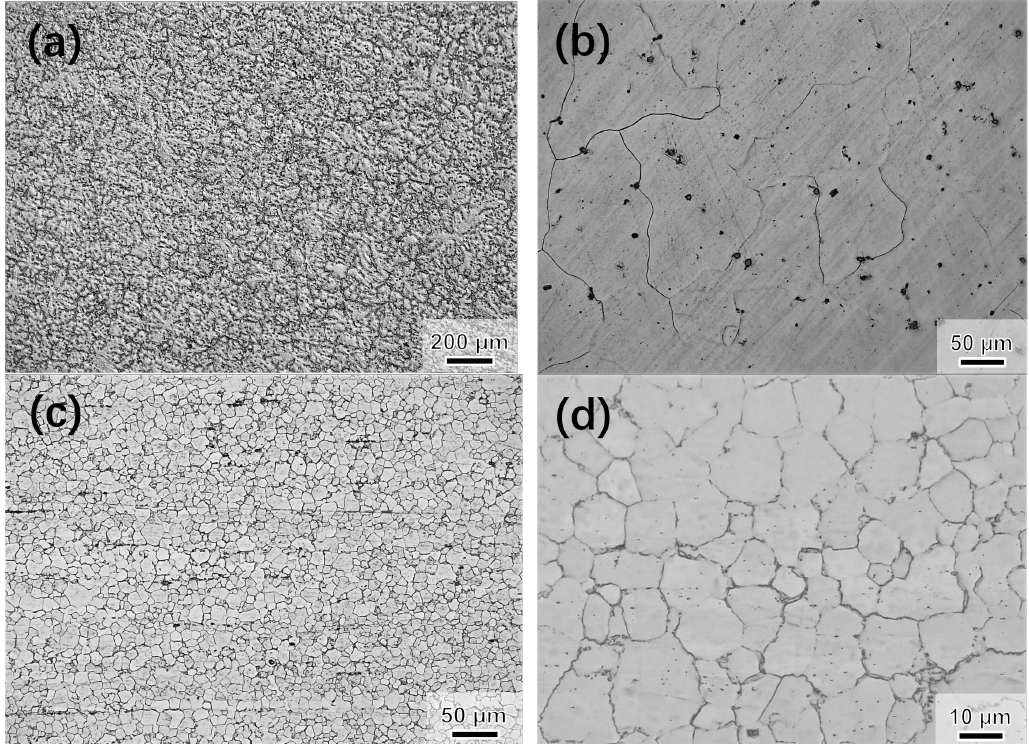
Figure 3. Optical microscope (OM) images of ( a ) the as-cast, ( b ) as-homogenized, and ( c , d ) as-extruded AZ80 alloy.